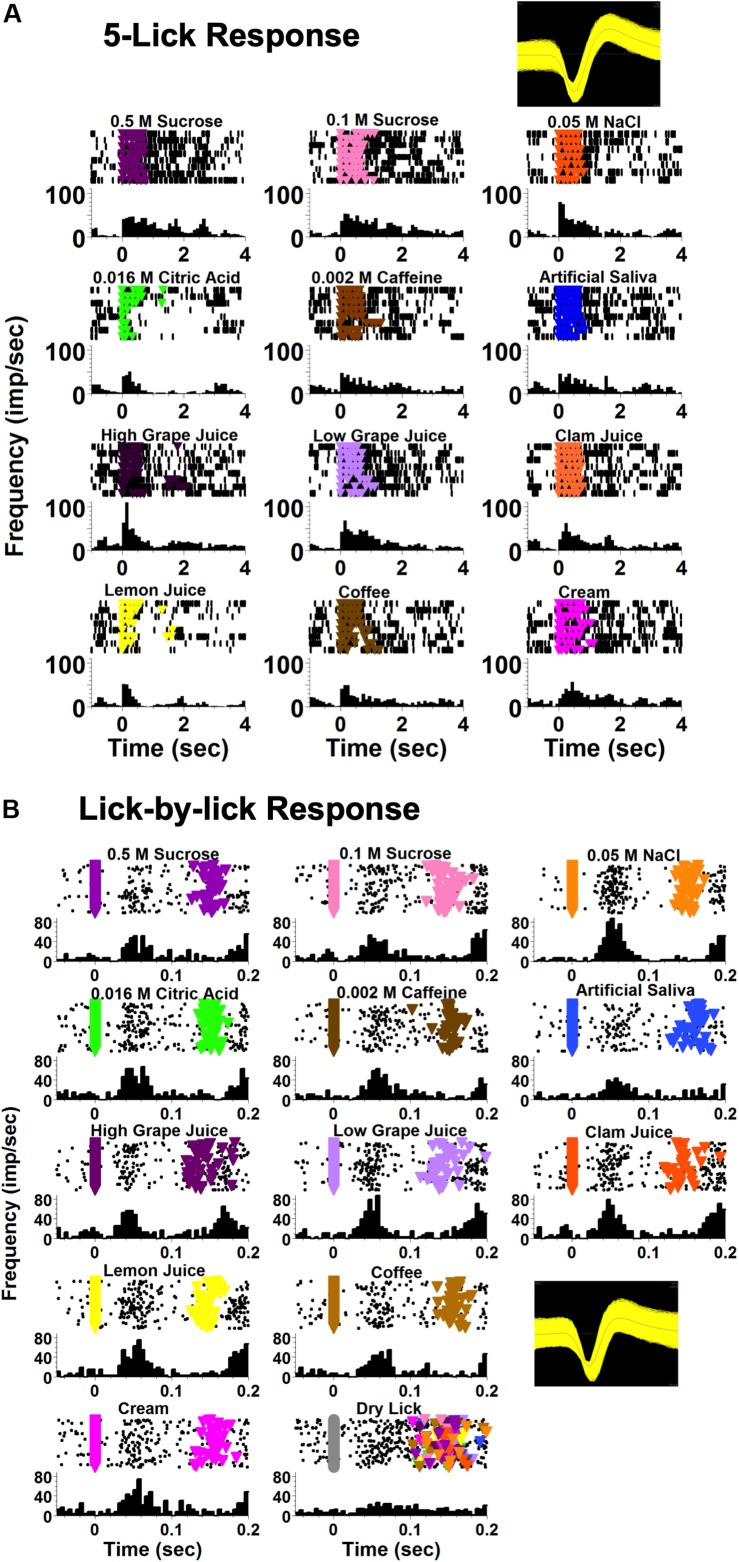
Examples of NTS taste responses on different time scales, recorded from two different cells. Both cells were recorded from a lean rat. (A) An example of a taste-responsive NTS neuron with a 5-lick response to taste. The first lick of the 5-lick stimulus trial is at zero; time bins are 100 ms. (B) An example of a taste-responsive NTS neuron with a lick-by-lick response. Each individual stimulus lick is positioned at zero; time bins are 5 ms. For both (A,B) each panel shows rasters (top) and peristimulus time histograms (PSTHs; bottom). Colored triangles in the rasters indicate a lick reinforced with a taste stimulus.